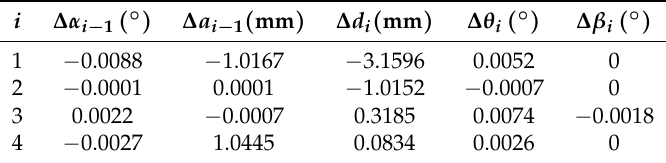
Table 2. The error compensation amount of the MDH parameter.